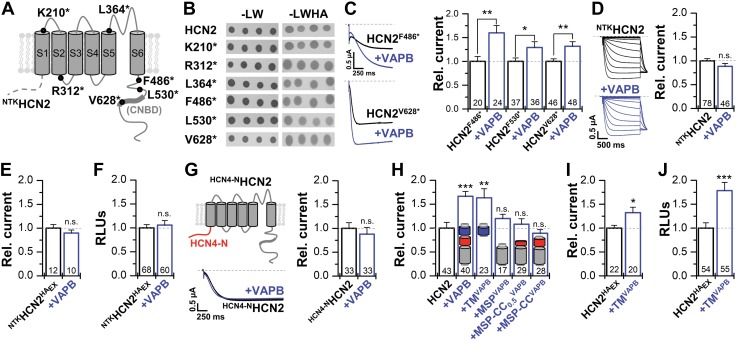
Domains mediating the interaction of VAPB with HCN2. A) Schematic illustration of a HCN subunit. The CNBD and some of the truncation constructs studied are indicated. B) All truncation constructs exhibited a positive interaction, evident from growth on -LWHA dropout medium. C) Representative current traces and the relative currents for different C-terminal deletions expressed alone or with VAPB. D) Representative current traces and the relative current amplitudes for the N-terminal truncated NTKHCN2 expressed alone or with VAPB. E) Relative current amplitudes of NTKHCN2HAEx (extracellular HA-tag) expressed alone or with VAPB. F) Relative surface expression of NTKHCN2HAEx expressed alone or with VAPB analyzed as relative light units (RLUs). G) Schematic illustration, representative traces, and currents of a HCN2 channel chimera with the N terminus of HCN4 (HCN4-NHCN2) expressed alone or with VAPB. H) Relative currents of HCN2 expressed alone or coexpressed with VAPB (1.7 ± 0.1), TMVAPB (1.6 ± 0.2), the MSP domain (MSPVAPB), the MSP with half of the CC domain (MSP-CC0.5VAPB), or with the complete CC domain (MSP-CCVAPB). I, J) Relative current amplitudes of HCN2HAEx expressed alone or with TMVAPB (1.3 ± 0.1) (I) and the respective changes in the relative surface membrane expression analyzed as RLUs, using a single cell chemiluminescence assay (TMVAPB 1.8 ± 0.2) (J). All data are presented as means ± sem. The number of experiments (n) is indicated in the respective bar graphs. N.s., not significant. *P < 0.05, **P < 0.01, ***P < 0.001 [unpaired Student’s t test (E), Mann-Whitney U test (C, D, F–H, J), or Welch’s t test (I)].